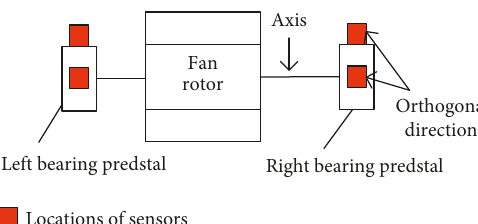
Figure 23: The schematic diagram of the experimental